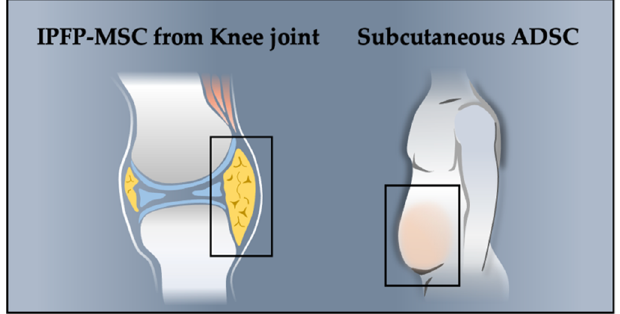
Figure 1. Primary sources of adipose-derived stem cells (ADSCs) in treating OA: infrapatellar fat pad–derived mesenchymal stem cells (IPFP-MSCs) and subcutaneous ADSCs. Patient age is a crucial parameter that sometimes limits the success of cell